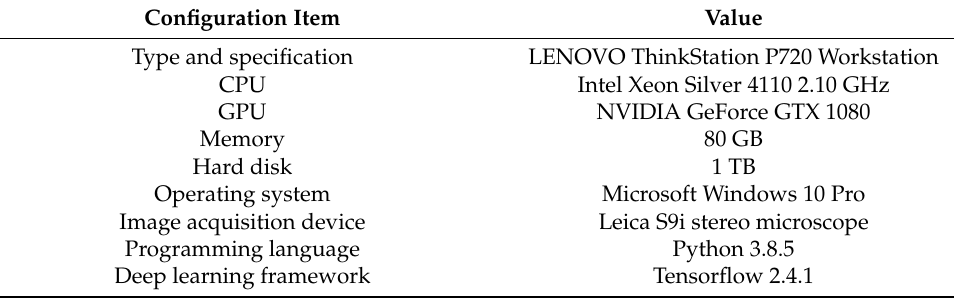
Table 1. Hardware and software